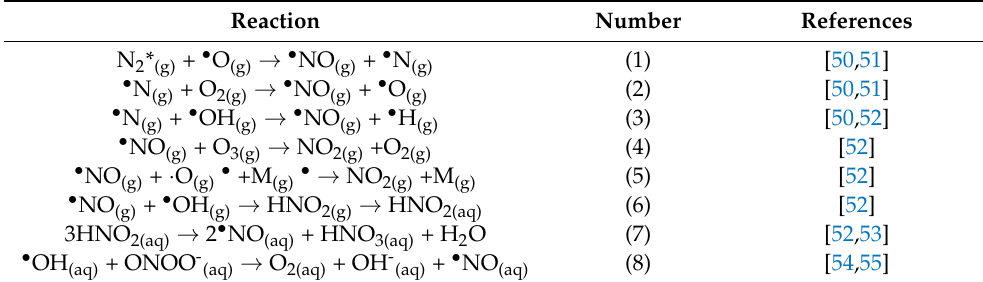
Table 3. Reactions representing the possible chemical formation routes of • NO in PTWS. Reaction